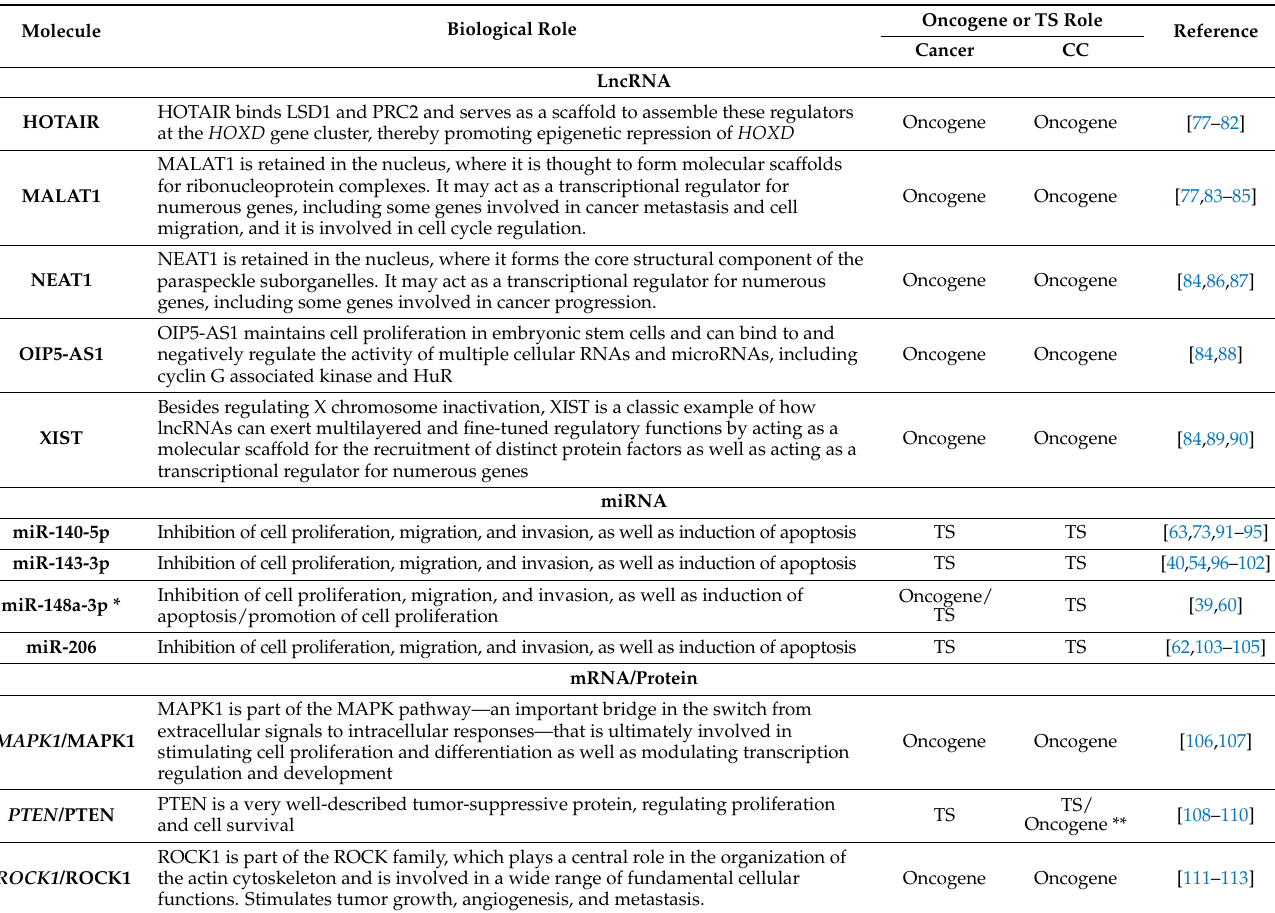
Table 4. Main biological roles, pathways, and the oncogenic/tumor-suppressive status of important RNAs involved in lncRNA-mediated axes in